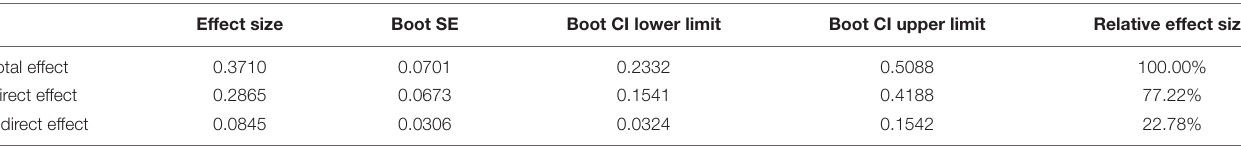
TABLE 3 | Total effect, direct effect, and indirect effect among the